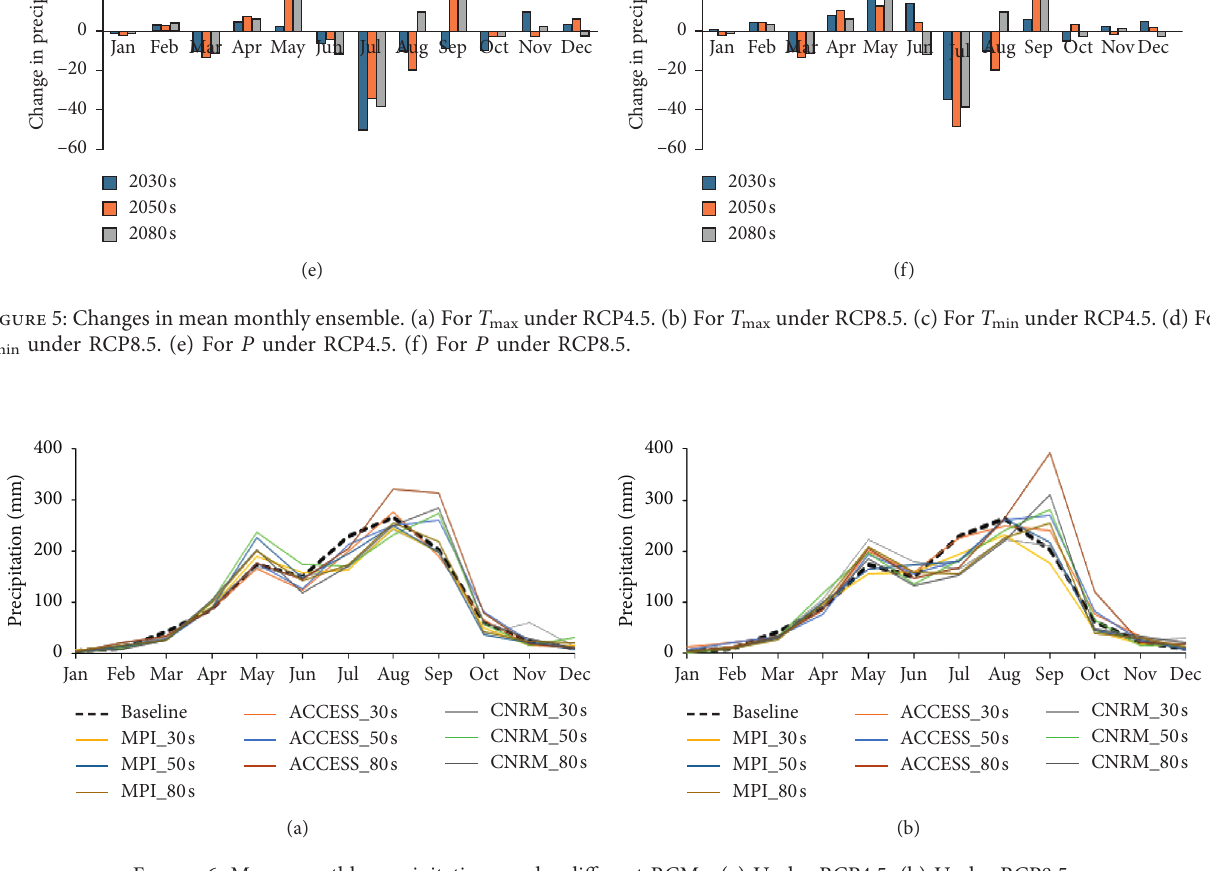
Figure 6: Mean monthly precipitations under different RCMs. (a) Under RCP4.5. (b) Under RCP8.5.